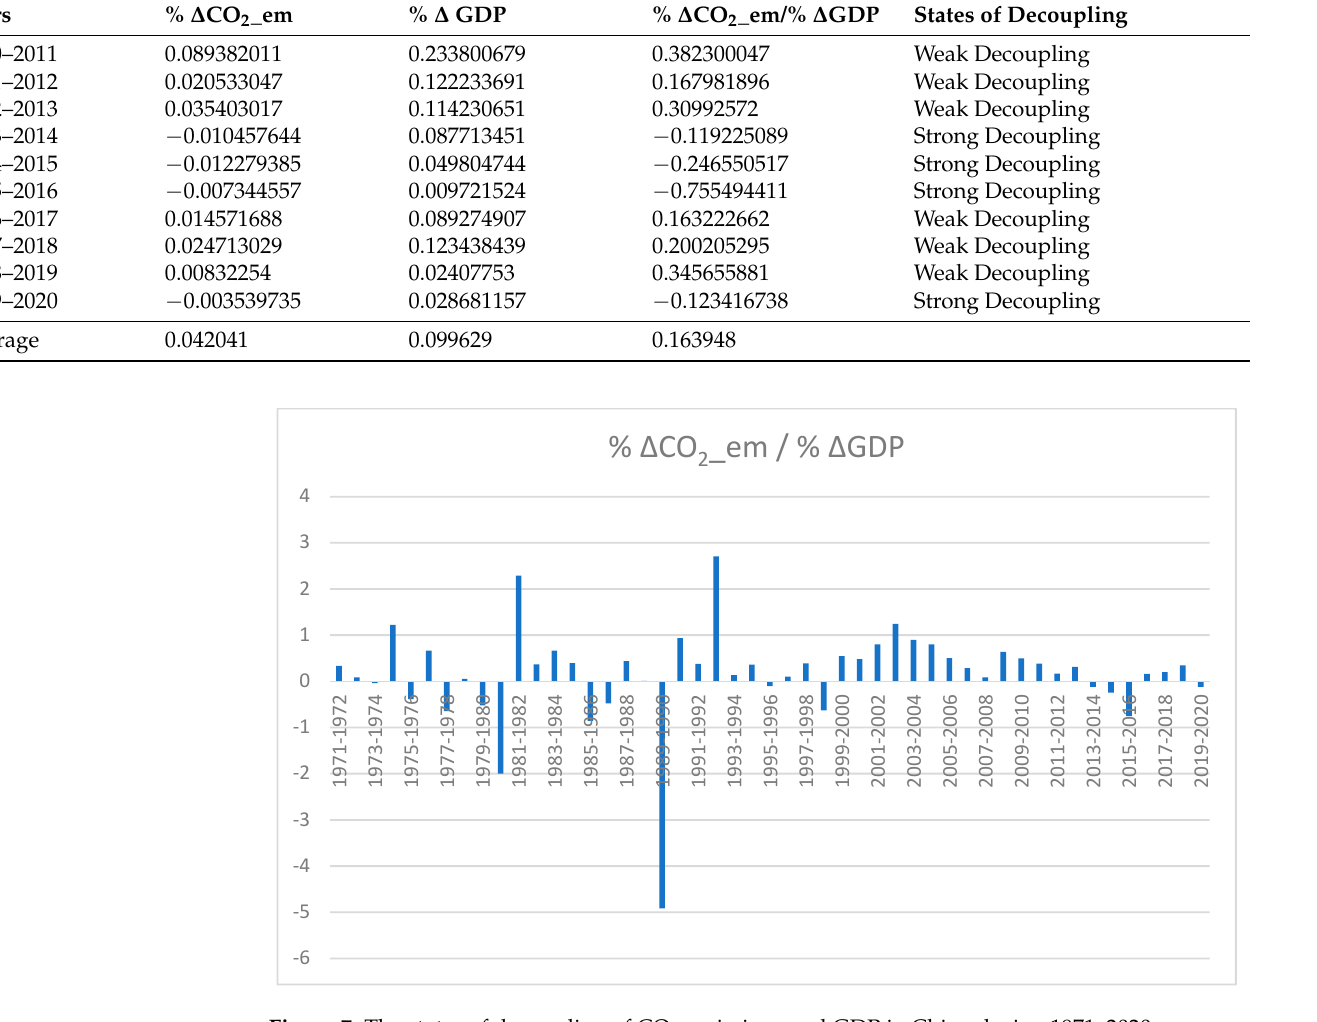
Figure 7. The states of decoupling of CO 2 emissions and GDP in China during 1971–2020.